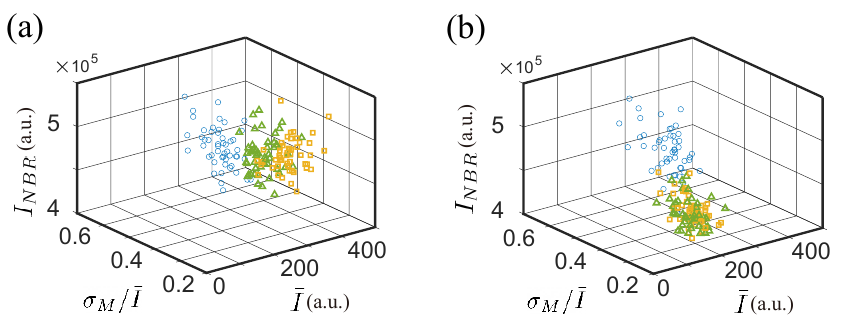
Figure 12. Experimental proof of the limits of NSGA2 and SBGA. Population evolution with three discriminants for ( a ) NSGA2 and ( b ) SBGA with equally weighted ranking coefficients ( a , b , c ) = ( 1,1,1 ) . Solutions from the 1st, 300th, and 600th generations are shown. To better illustrate the flexibility to control search direction and quality offered by SBGA, the populations from three generations with different coefficients are shown in Figure 13a–c. The relation between the neighboring intensity and the average intensity of targets is shown in Figure 13d–f. The solid line in each 2-D plot indicates the trend of the corresponding 3-D plot (Figure 13a–c) and the dashed lines are used for comparison with the trends of the two other 3-D plots.